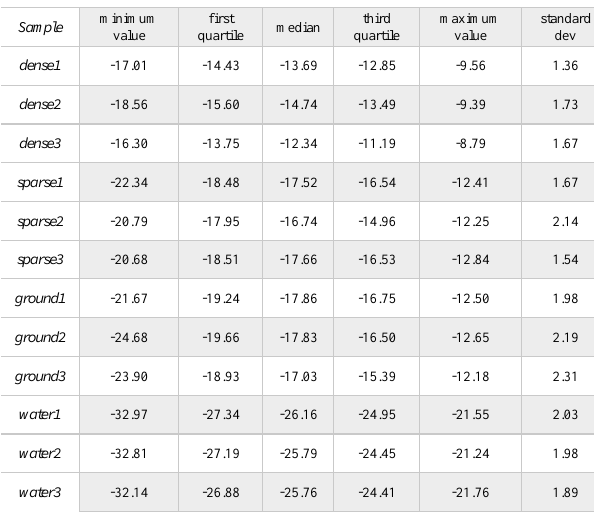
Figure 7. VH backscatter values of the samples (dB), from the boxplot from Figure 5.